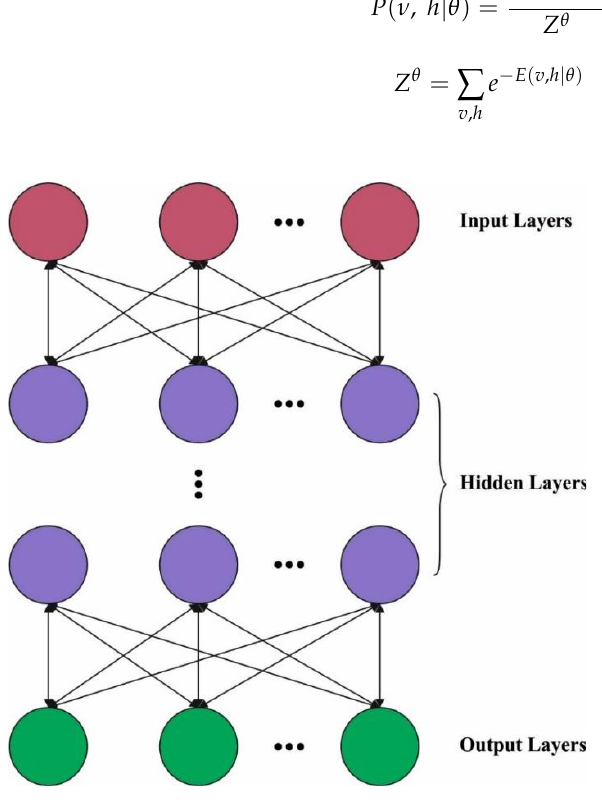
Figure 2. Structure of DBN.